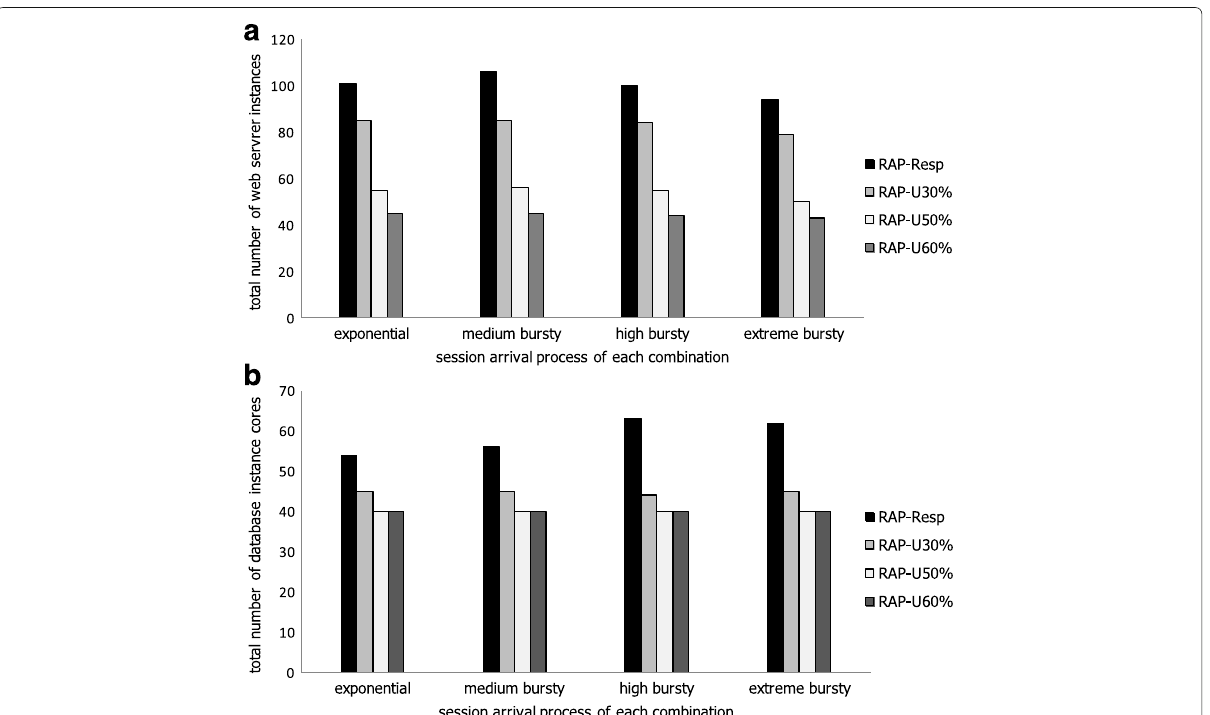
Fig. 11 Response time vs. Utilization based SLP. a Web server instances. b Database instance